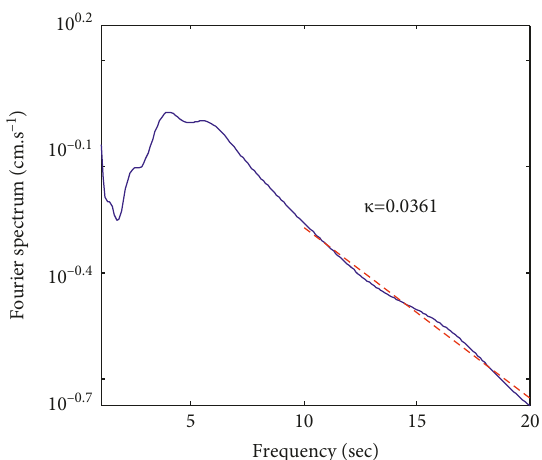
Figure 6: Calculation diagram of κ using the vertical component of Fourier spectrum at 051YBT in Changning mainshock.